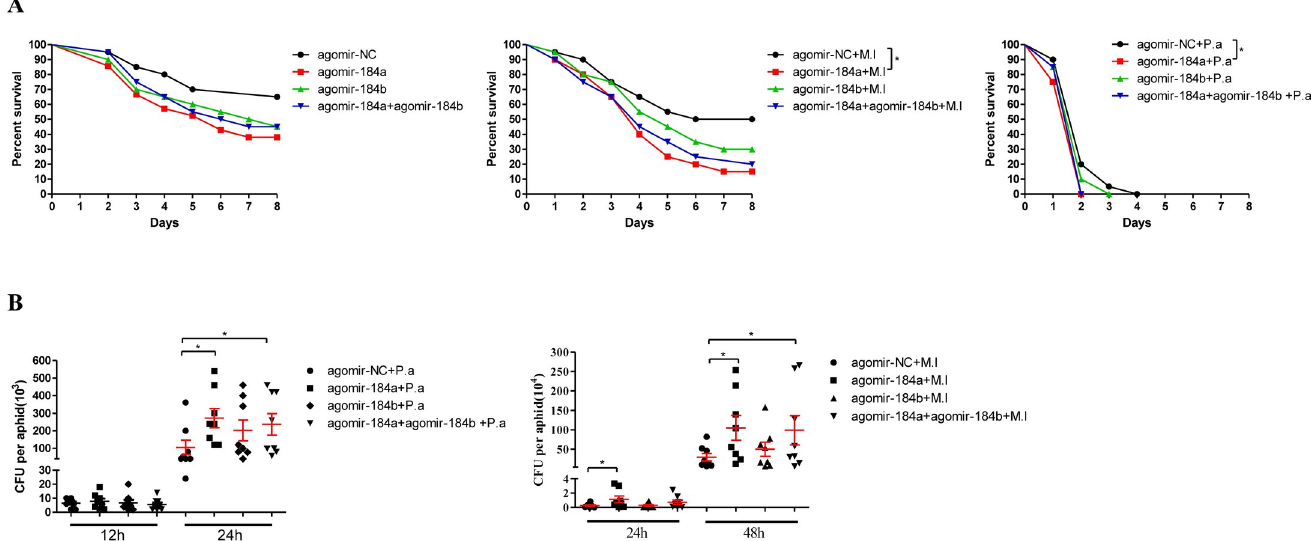
Fig 7. miRNA-184a/b affected pea aphid survival and bacteria multiplication after infection. (A) Effect of injection of agomir-184a, agomir-184b and half-dose agomir-184a plus half-dose agomir-184b on the survival of pea aphids after M . luteus (M.l) and P . aeruginosa (P.a) infection with the aphids injected by sterile 0.85% as control groups, n = 20. Survival graphs show one representative experiment out of three independent experiments with similar results. The statistical differences between the compared groups were denoted with asterisks. The log-rank (Mantel-Cox) test was used to analyze pea aphids’ survival curves. � P < 0.05. (B) Effect of injection of agomir-184a, agomir-184b and half-dose agomir-184a plus half-dose agomir-184b on the bacterial load of pea aphids after M . luteus (M.l) and P . aeruginosa (P.a) infection, n = 8. Each dot in the graph represents an individual aphid. The horizontal bars indicate mean values and the vertical bars indicate the SEM of the replicates. The statistical differences between the compared groups were denoted with asterisks. P values were determined by Student’s t test. � P < 0.05.